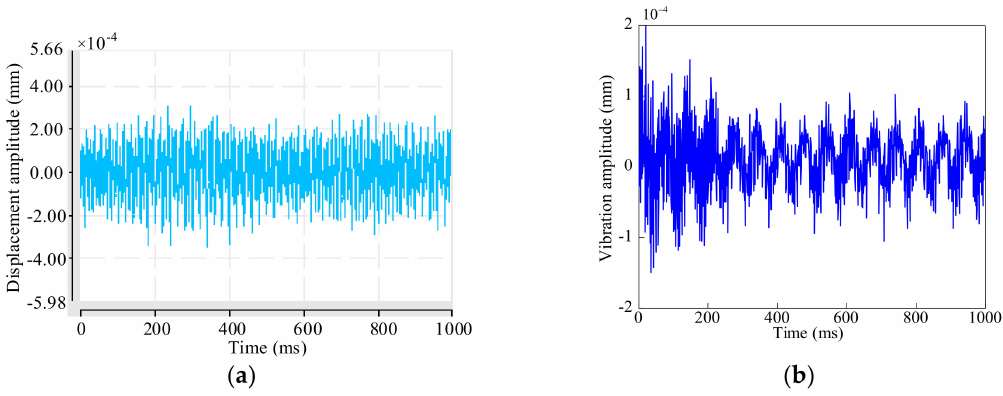
Figure 11. Comparison of radial vibration displacement waveforms. ( a ) Measured vibration displacement waveform; ( b ) Simulated vibration displacement waveform.